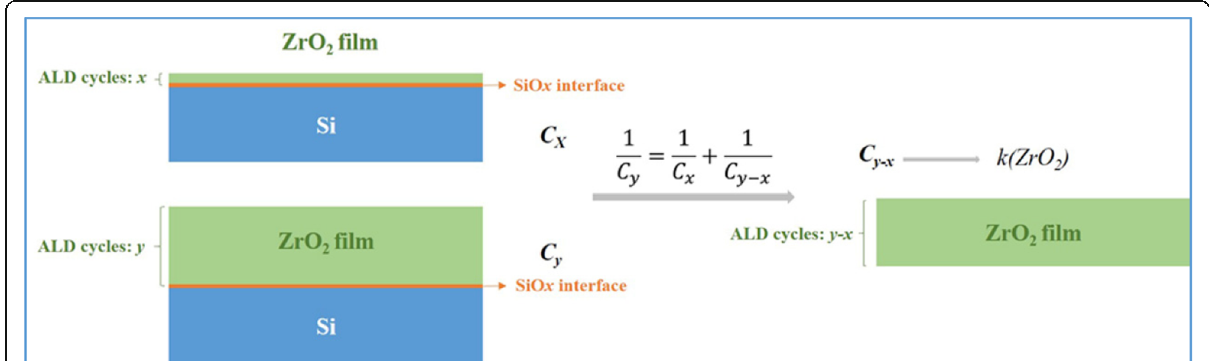
Fig. 10 Schematic diagram of dielectric constant